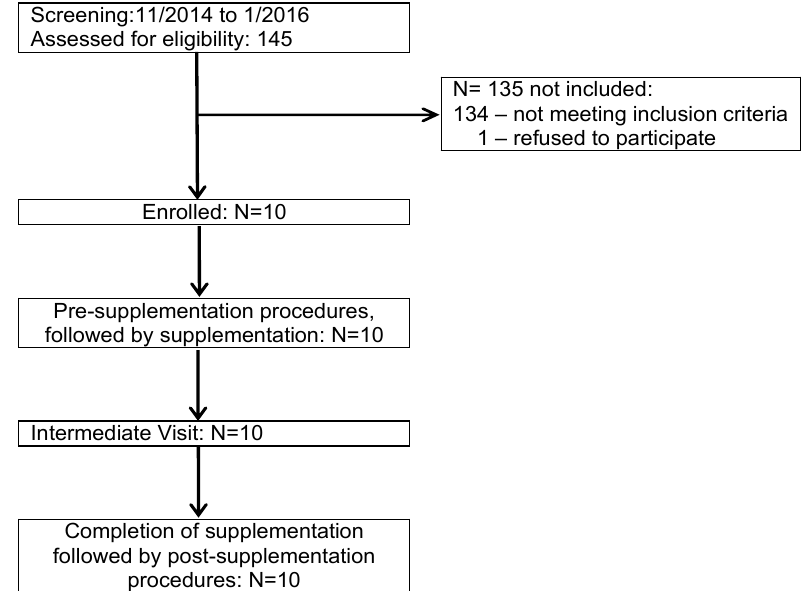
Figure A1. Patient flow of choline supplementation pilot study in adult male CF patients. The protocol was approved by The Institutional Review Board, and registered at ClinicalTrials.gov (Identifier: NCT 03312140). Table A3. Anthropometric and laboratory parameters of patients.